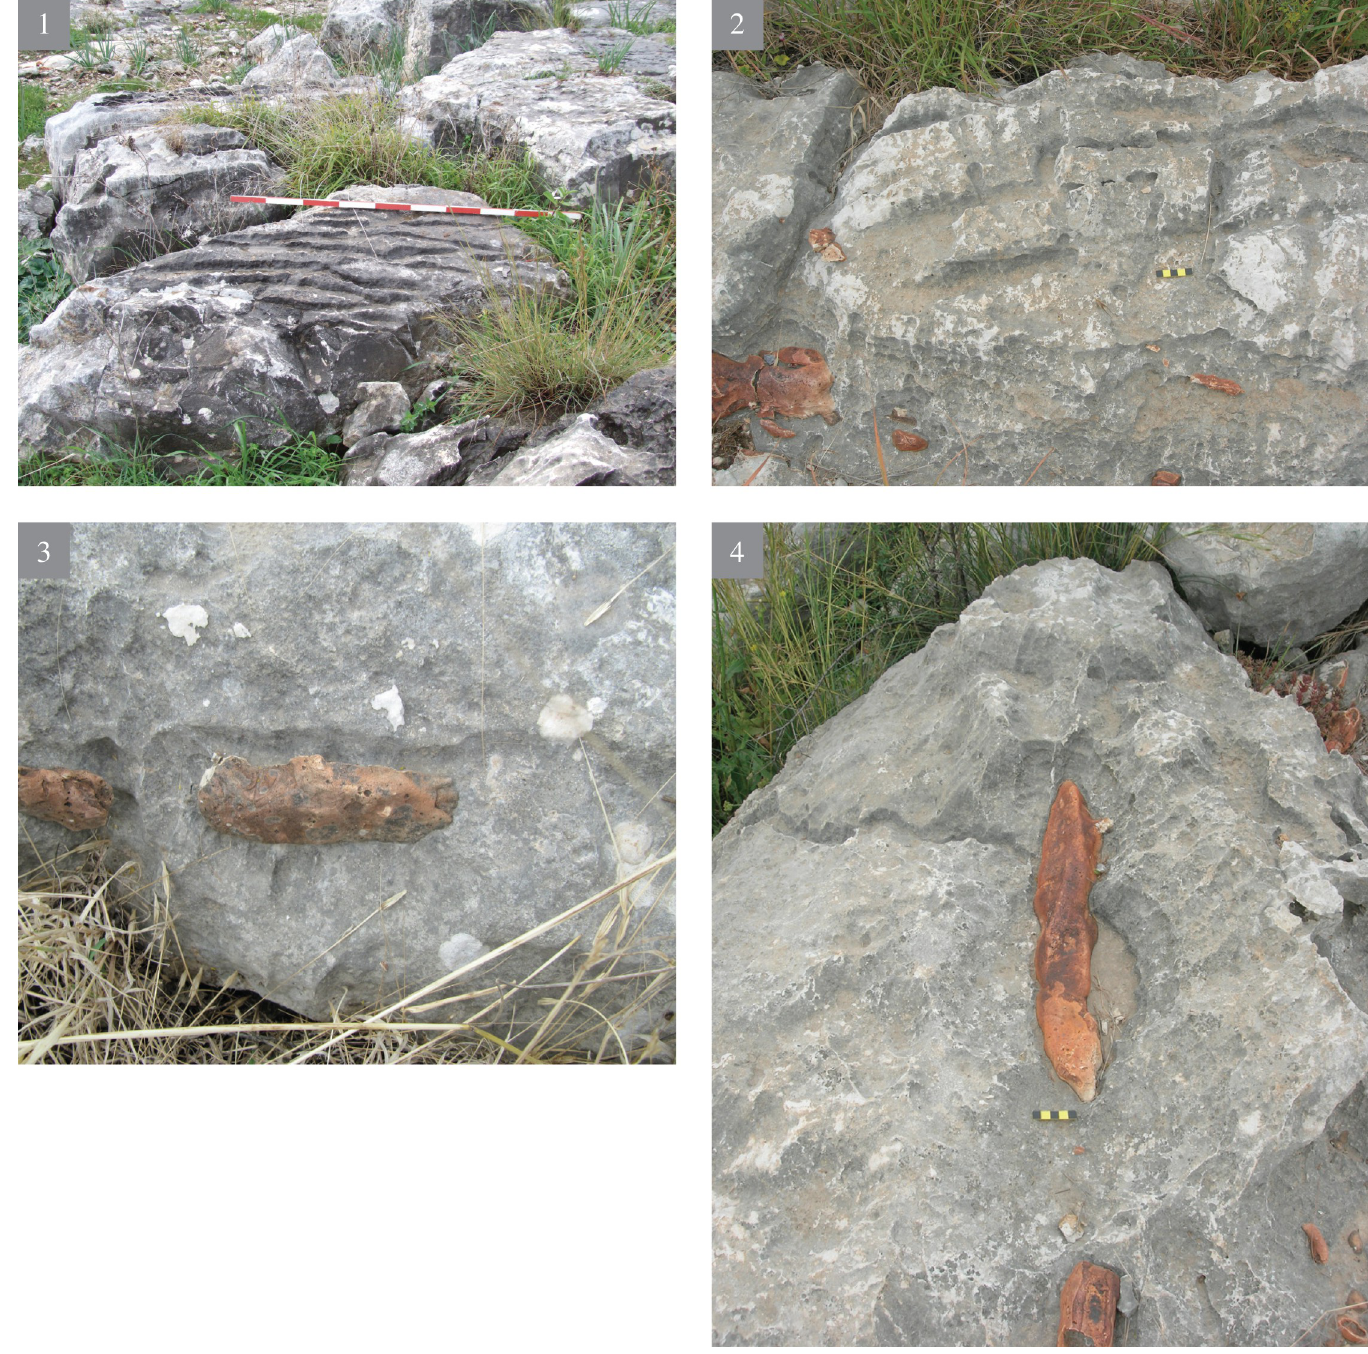
Fig 4. Rock damage resulting from flint quarrying of the Bi’na Formation bedrock (voids) and different types of quarrying marks